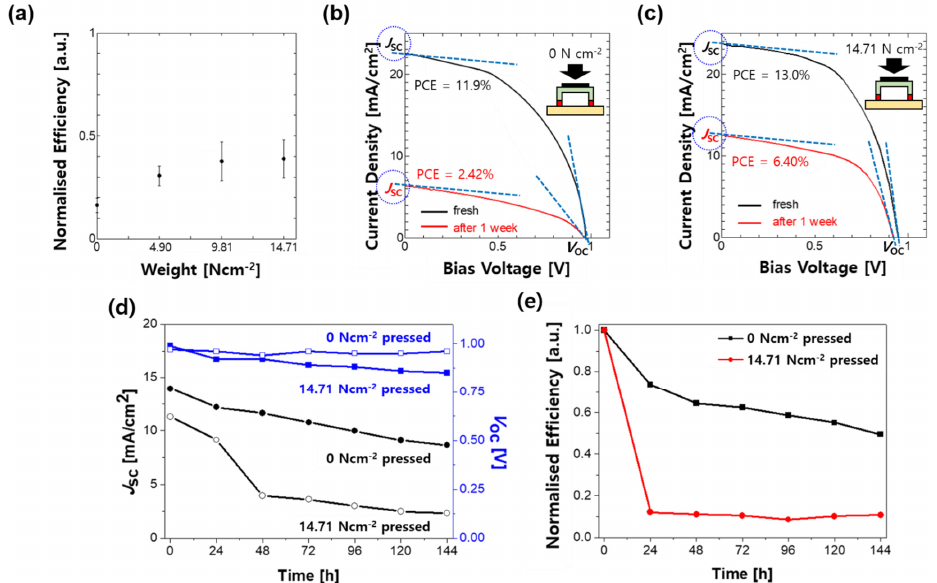
Figure 2. ( a ) Normalised efficiency drop of PSCs encapsulated under different applied pressures during the packaging process, left in the atmosphere after one week; ( b , c ) J–V curves of the encapsulated PSCs under ( b ) 0 N cm − 2 and ( c ) 14.71 N cm − 2 before and after being left in the atmosphere for one week; ( d ) changes in J SC and V OC of the devices encapsulated under the applied pressures of 0 N cm − 2 and 14.71 N cm − 2 . ( e ) Decrease in the normalised efficiency during one week of the stability test for the PSCs encapsulated under the applied pressures of 0 N cm − 2 and 14.71 N cm − 2 . Table 1. Packaging type of the devices and solar cell performance values before and after one week of durability testing. More detailed corresponding J – V curves, EQE, and statistical information can be found in Figures S7, S15 and S16).